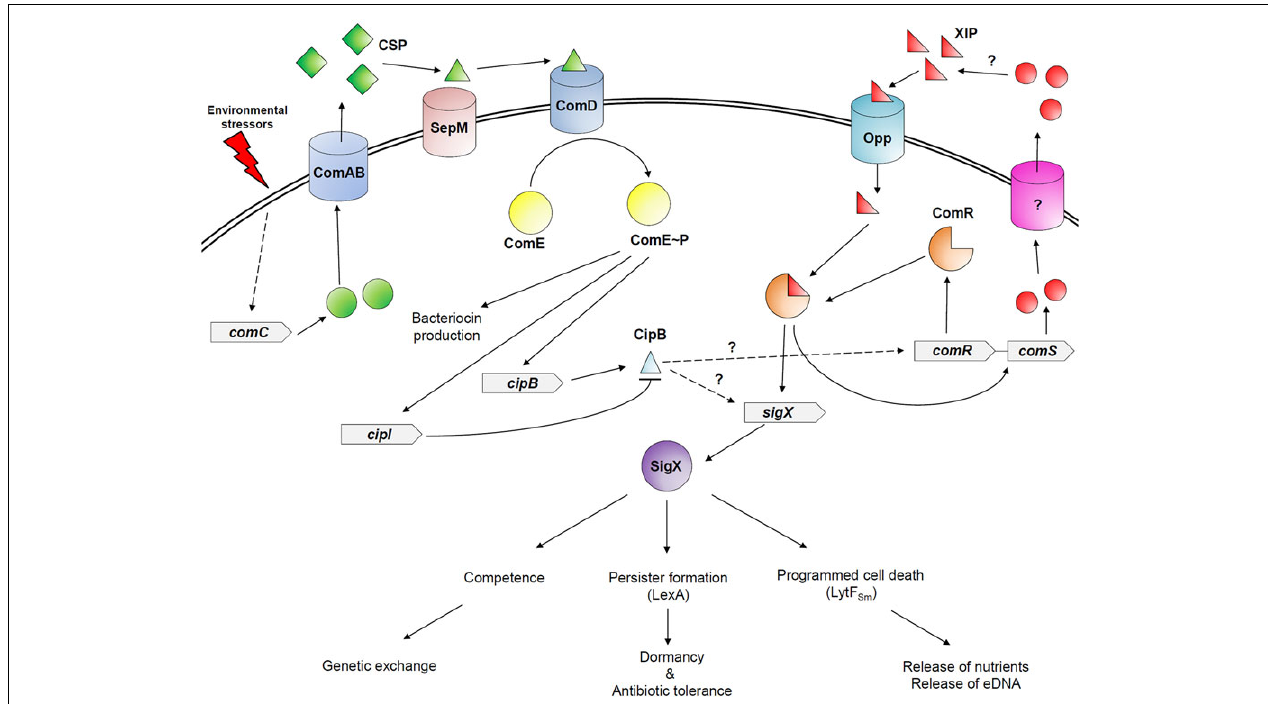
FIGURE 1 | The CSP-ComDE and ComRS quorum-sensing systems in S. mutans . Particular environmental stressors, such as those encountered in the oral cavity, induce the expression of the CSP-encoding gene ( comC ). The CSP propeptide is processed and exported by the specific ABC transporter, ComAB, into the extracellular milieu. A final post-export processing step is then mediated by the SepM protease. When the mature CSP pheromone accumulates to surpass a threshold concentration, it directly binds to the membrane-bound ComD receptor triggering its autophosphorylation, and the subsequent activation of the